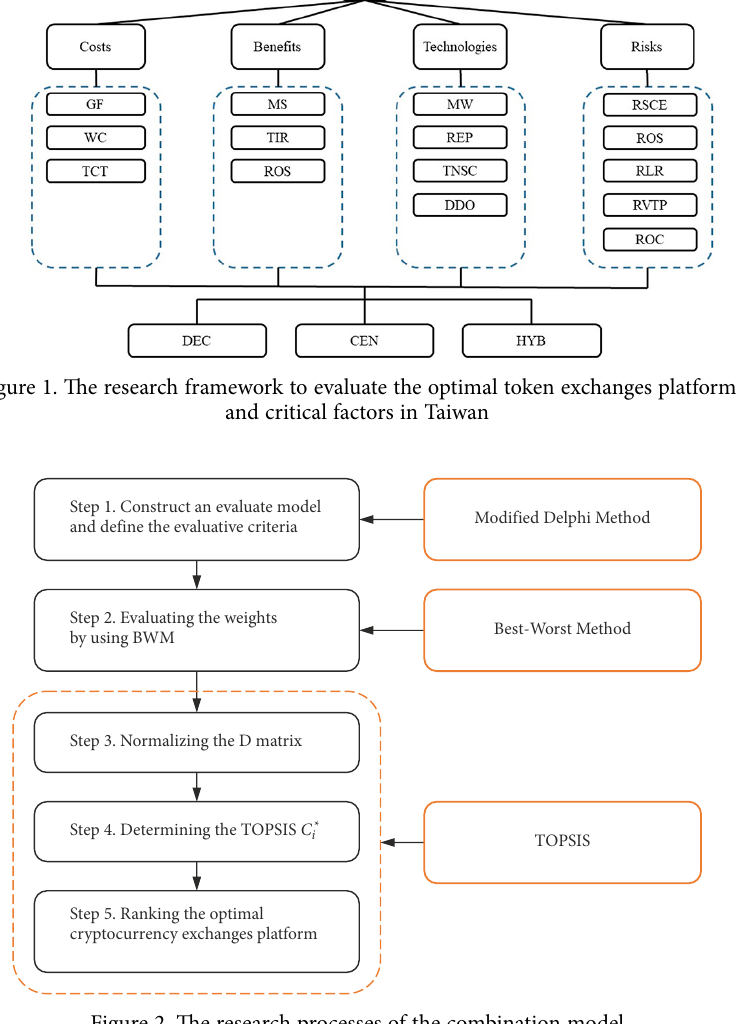
Figure 2. The research processes of the combination